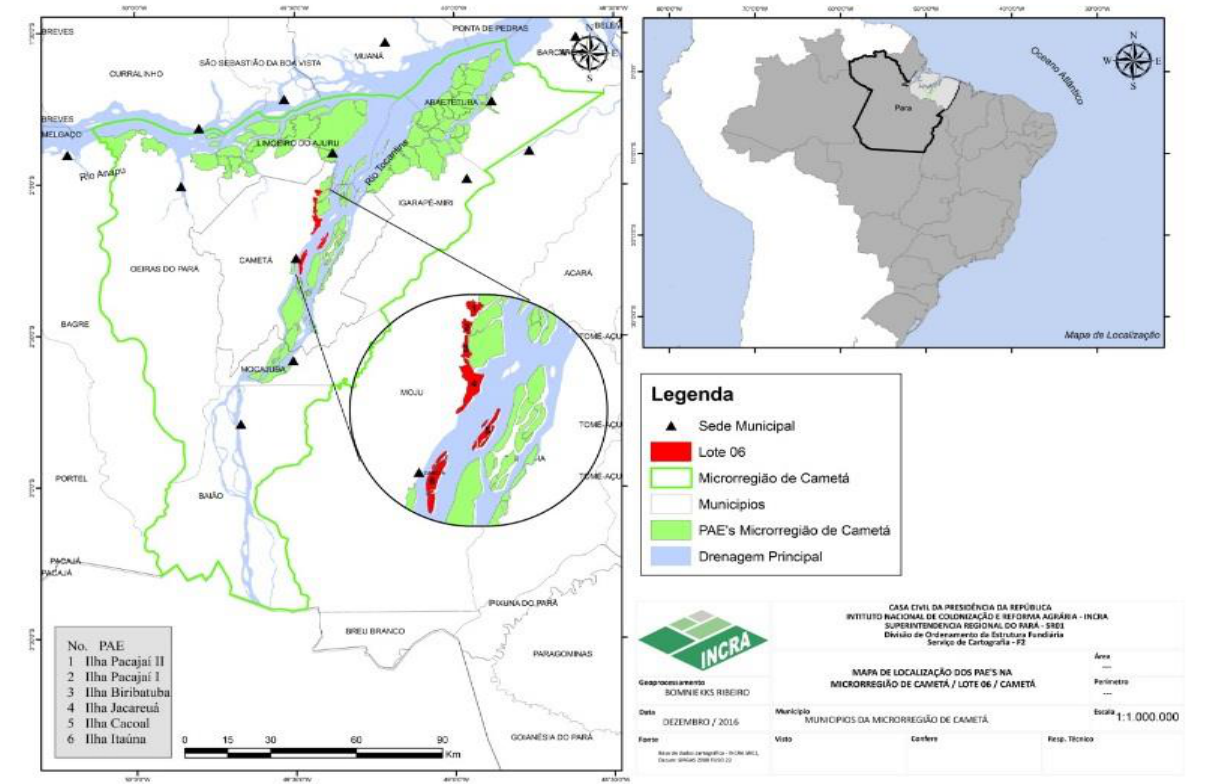
Figura 2: Mapa de Localização dos PAE´s na Microrregião de Cametá. Fonte: INCRA,